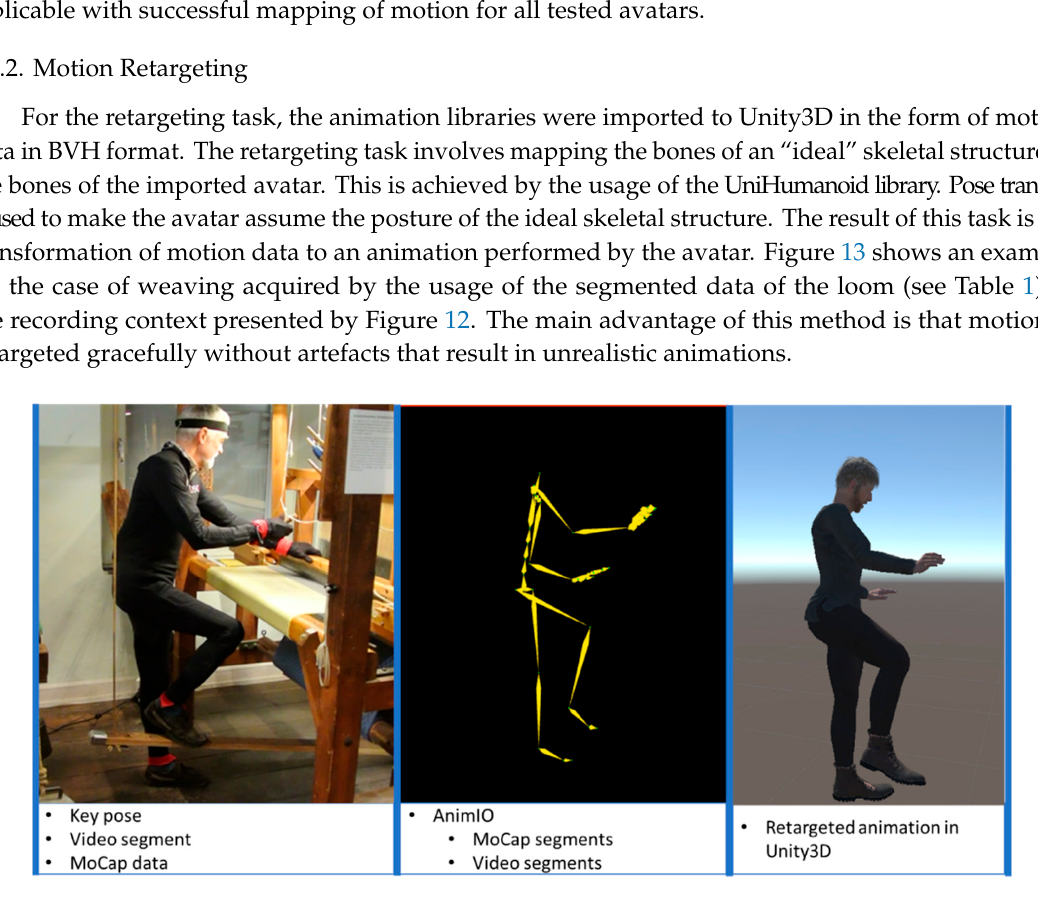
Figure 13. Weaving motion recording using NANSENSE system ( left ), segmented MoCap in AnimIO ( middle ), retargeted animation in Unity3D ( right ).